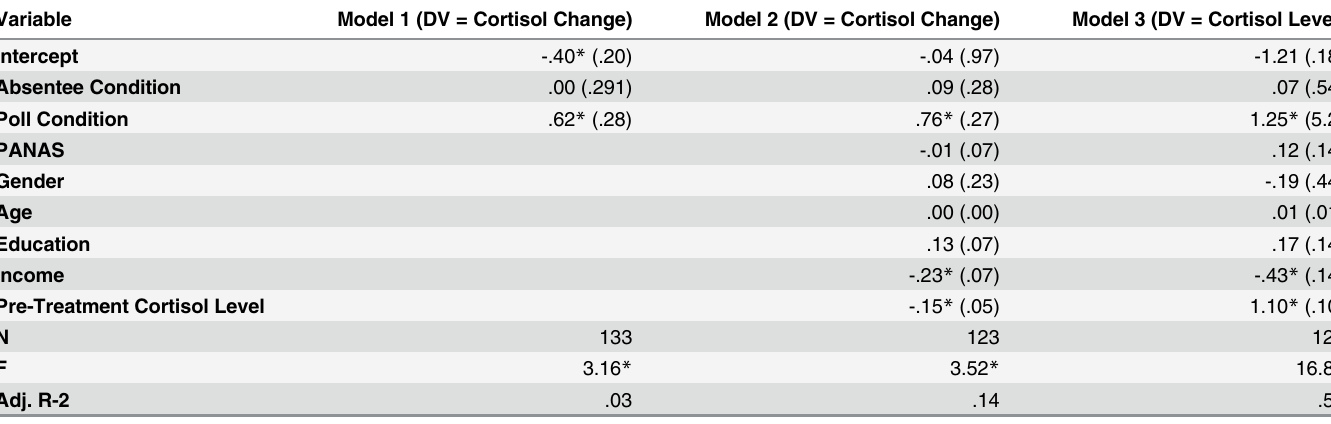
Table 3. Estimates of Cortisol Level Change by Experimental